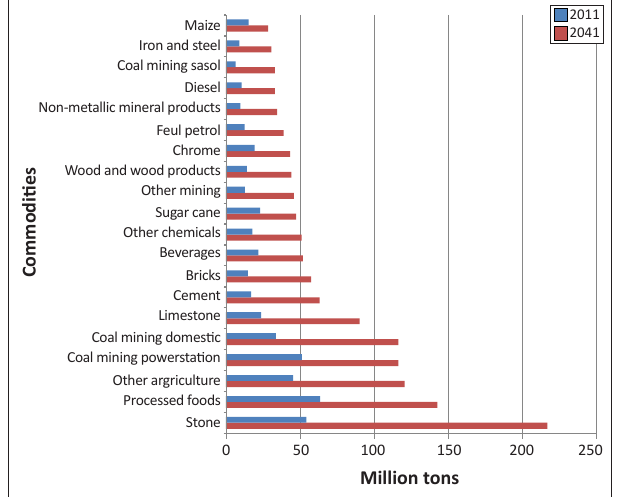
FIGURE 1: Top 20 commodities by absolute tonnage growth 2011–2041.